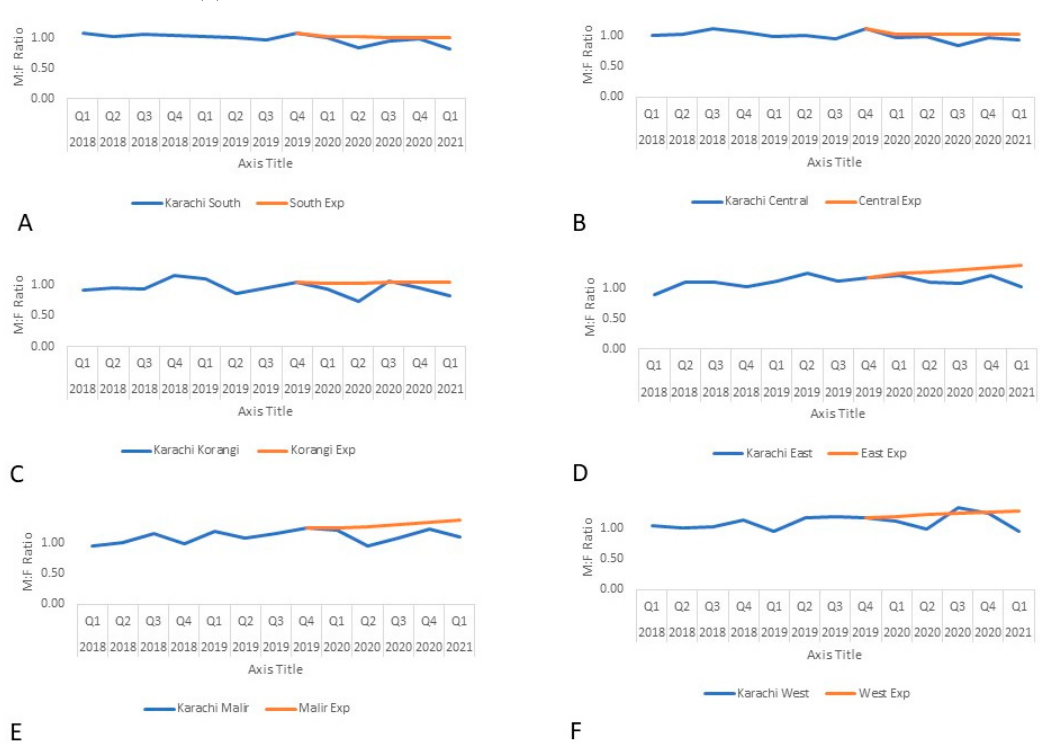
Figure 3. Actual and expected pediatric TB case notifications in Karachi by district from 2018–2021: ( A ) District South, ( B ) District Central, ( C ) District Korangi, ( D ) District East, ( E ) District Malir, ( F ) District West.